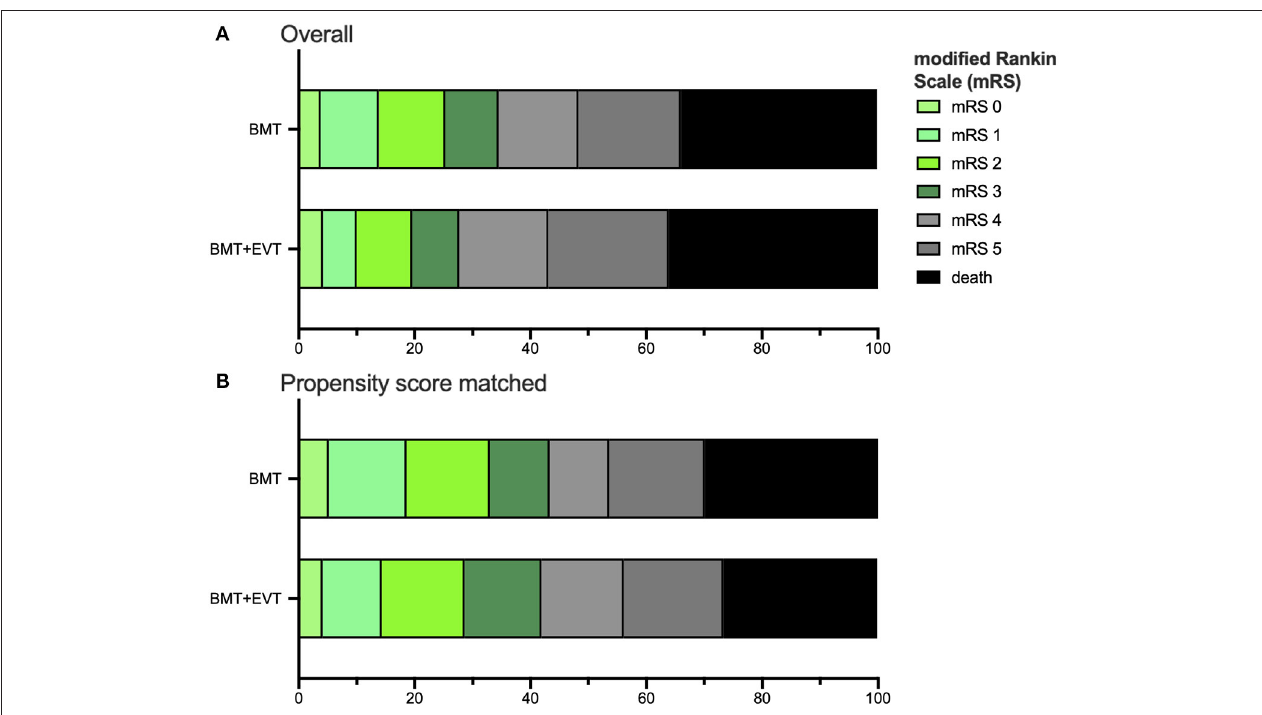
FIGURE 1 | Distribution of the modified Rankin scale (mRS) in all patients (A) and the Propensity Score matched data set (B) for age, mRS at admission, baseline NIHSS, and medical history, such as diabetes mellitus, arterial hypertension, and prior stroke. Comparing BMT vs. BMT plus EVT group, the mRS shift was not significant, neither for the all patients [OR 0.81 (0.56–1.19)] nor for Propensity Score matched patients [OR 0.98 (0.60–1.61)]. The ratio was estimated with ordinal logistic